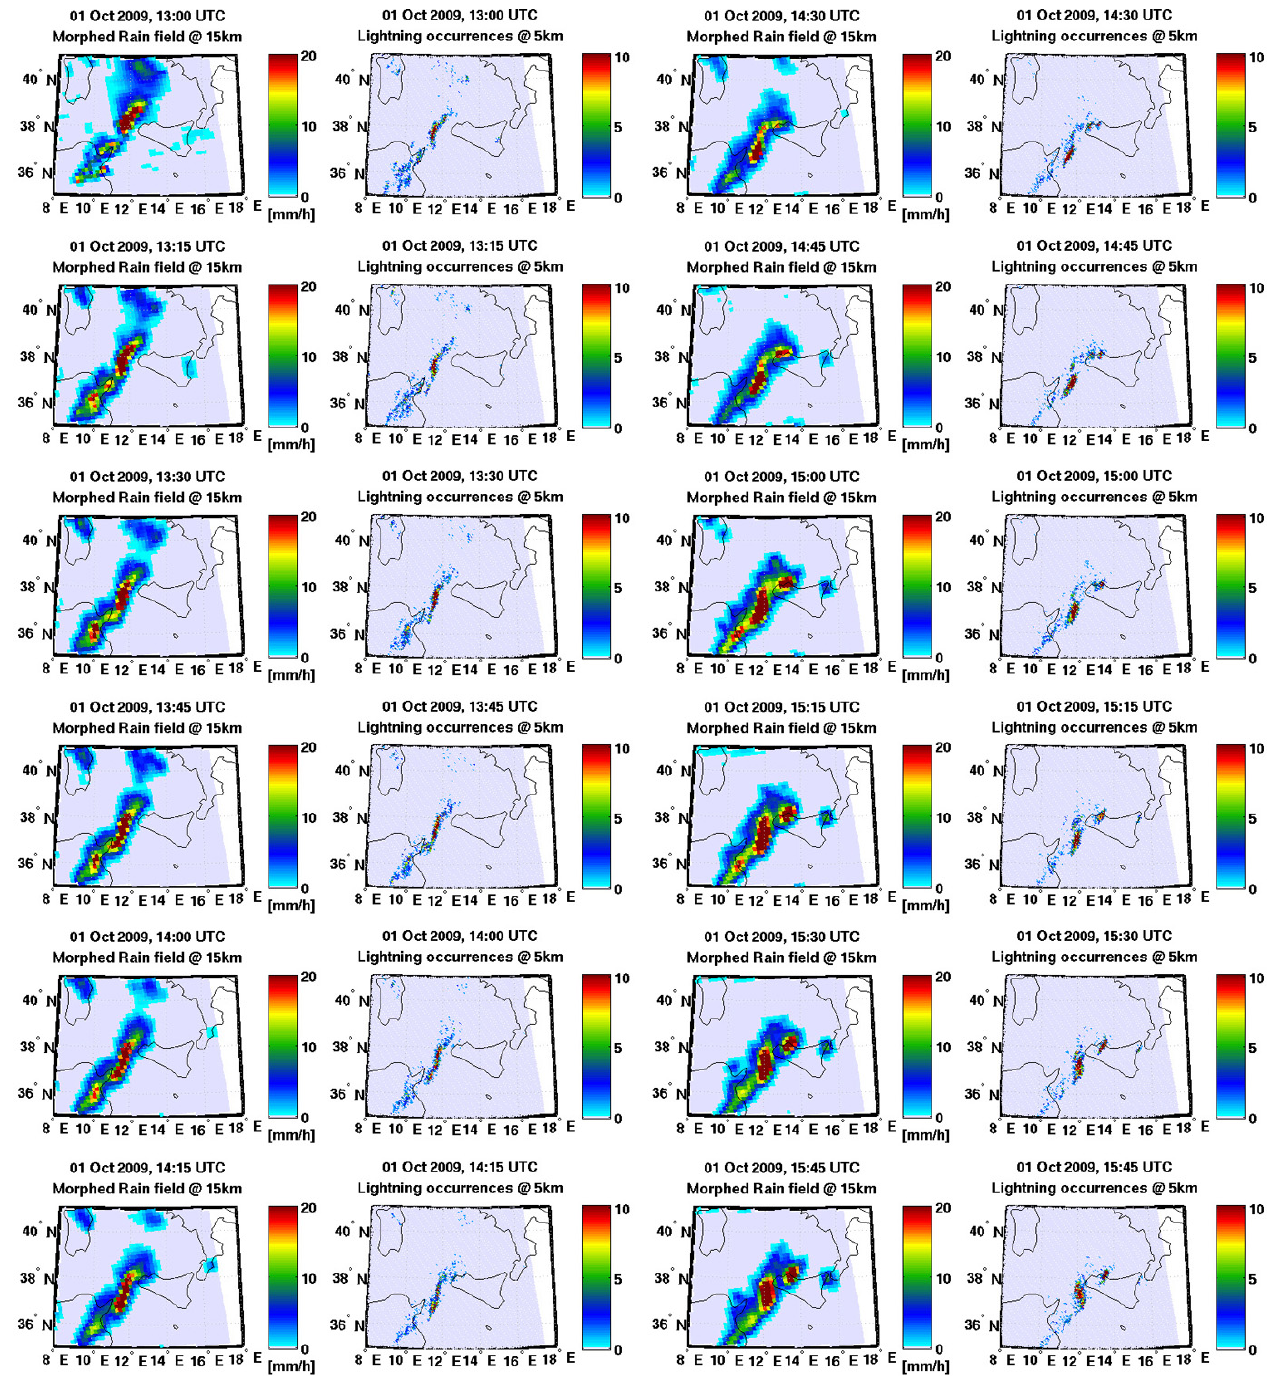
Fig. 6. Event over southern Italy, 1 October 2009. L-PET estimated rain field evolution from 13:00UTC to 15:45UTC, starting from the rain field provided by the AMSU-based algorithm applied to TB from NOAA 18 satellite, and contemporary lightning occurrences used for the